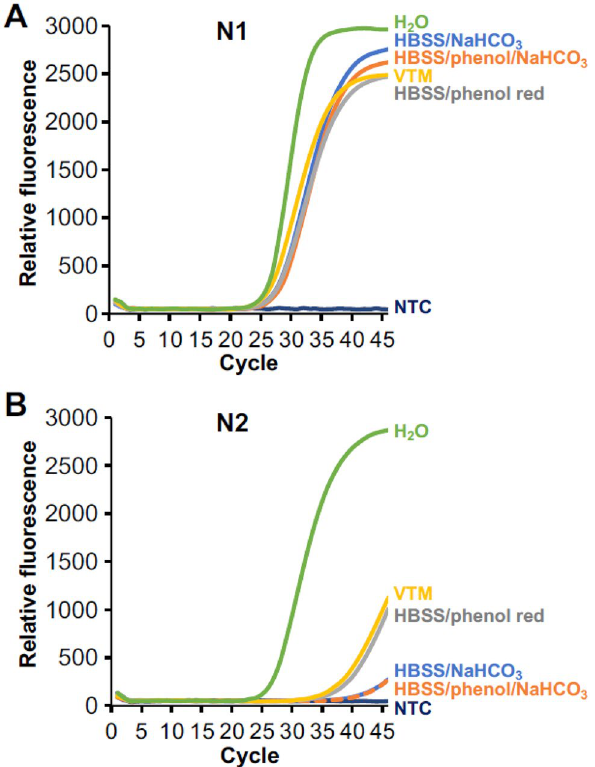
Figure 1. Comparison of the qRT-PCR performance of the ( A ) N1 and ( B ) N2 primer set with VTM and similar media added using the CDC SARS-CoV-2 qRT-PCR protocol. N2 reactions are negatively impacted for all media tested. Each curve is the average of two experiments (N =